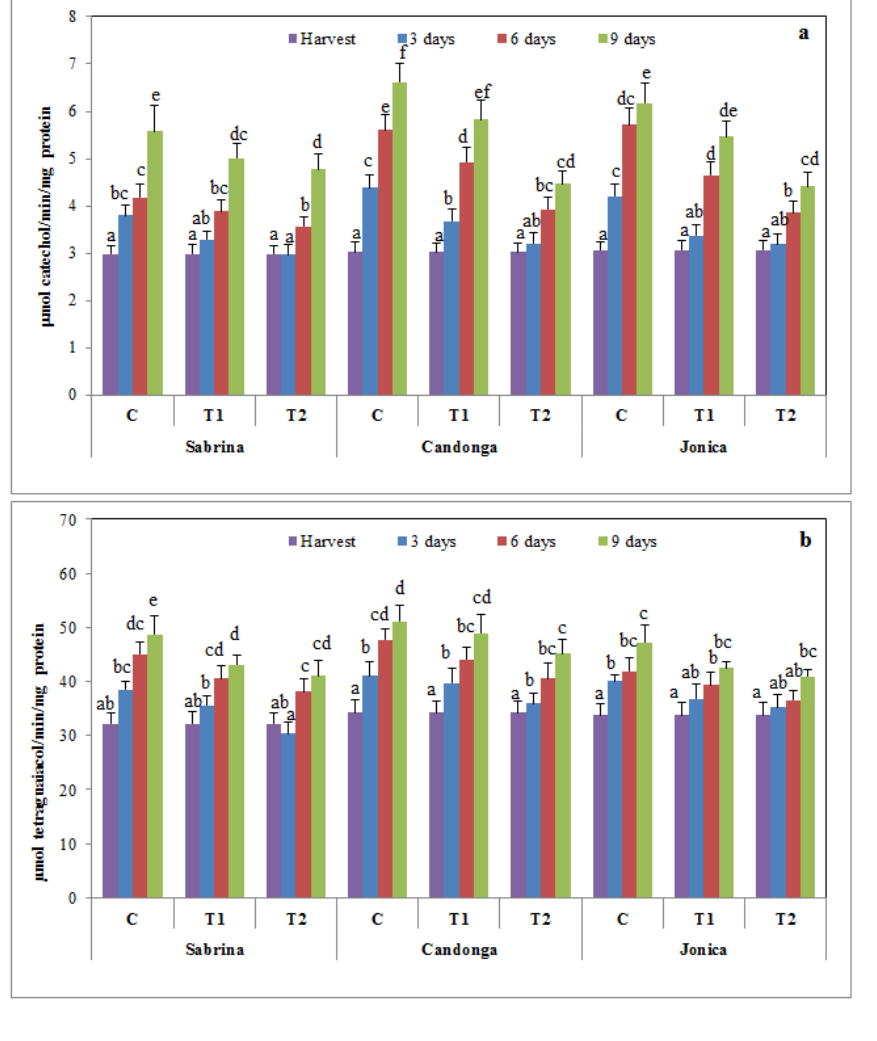
Figure 7. Changes in polyphenol oxidase (PPO) ( a ) and guaiacol peroxidase (GPX) ( b ) activity of strawberry cultivars during cold storage at 2 °C for nine days (error bars indicate standard